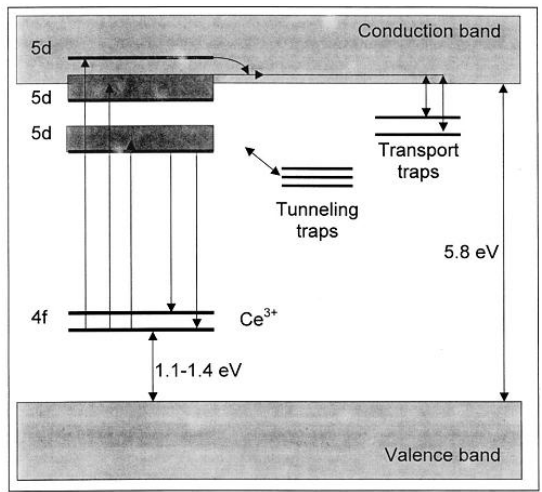
Figure 4. Energy level diagram for CaAl O : Ce 3+ , showing the positions of the Ce 3+ levels 2 4 relative to the bandgap of the host and the proposed trapping mechanism. After excitation in the conduction band, trapping occurs through the conduction band. After excitation in the lower 5d levels, trapping occurs through tunneling (Reprinted with permission from [77]. Copyright 2003 The Electrochemical